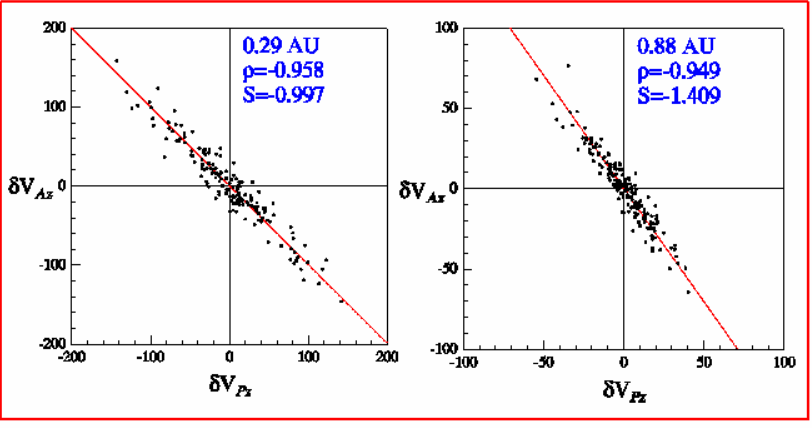
Figure 41: Scatter plot between the 𝑧 -component of the Alfv´en velocity and the proton velocity fluctu- ations at about 2 mHz. Data refer to Helios 2 observations at 0.29 AU (left panel) and 0.88 AU (right panel). Image adapted from Bavassano and Bruno